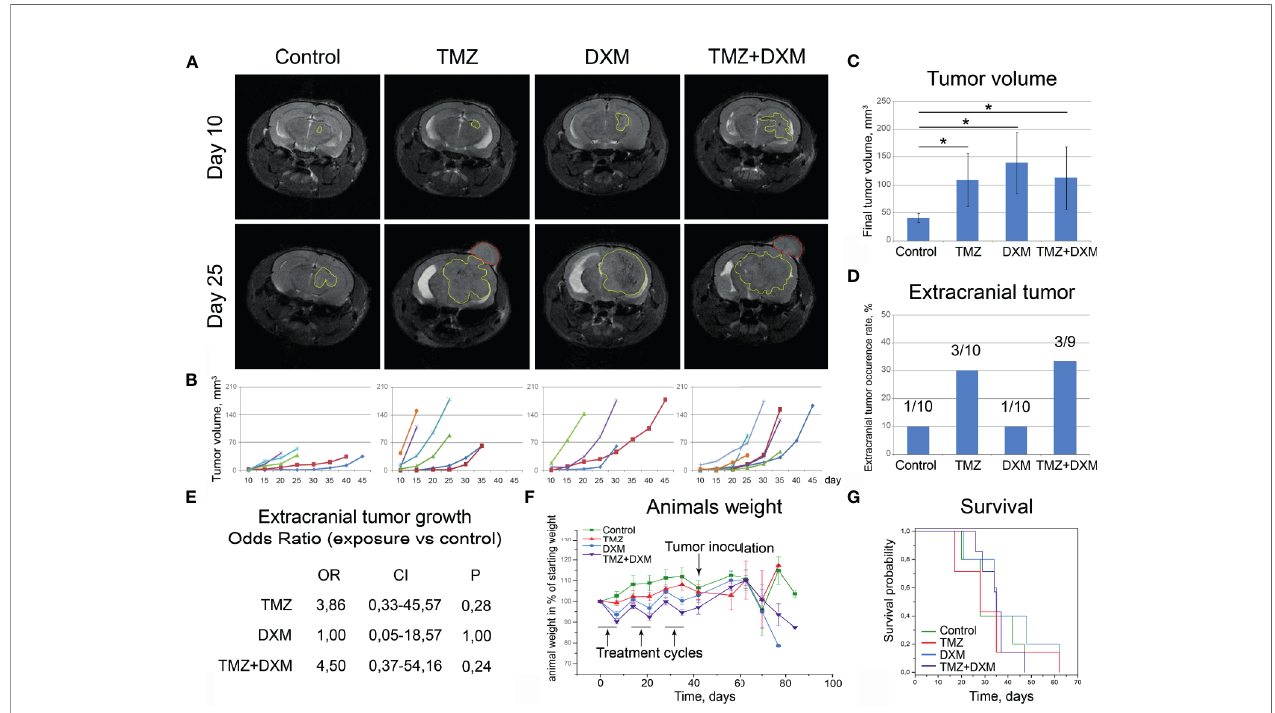
FIGURE 3 | Functional effects of TMZ and/or DXM-induced changes in brain tissue on the development of experimental U87 xenograft tumors. (A) MRT-images of the representative U87 xenografts. Intracranial tumors marked with a yellow outline, extracranial — red outline. (B) Growth curves for the xenografts in control and treated brains. (C) Final volume of the xenografts. ANOVA and post-hoc Fisher ’ s LSD test, *p < 0.05. (D) Frequency of the extracranial tumors in all experimental groups. (E) Odds ratio of extracranial tumors development (OriginPro 8.5). (F) Weight of the animals during the experiment. (G) Survival of the animals (Kaplan-Meier curve). TMZ, temozolomide; DXM,